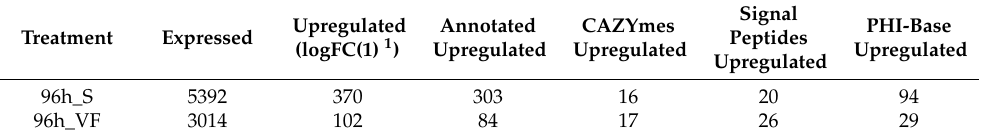
(Table S4). A subset of 303 genes expressed in 96h_S were not detected in 96h_VF elms, whereas only one gene (OnuG2030) expressed in 96h_VF ( n = 1.7 transcripts) was not in 96h_S elms. Table 2. Summary of categories in Ophiostoma novo-ulmi ssp. americana differentially expressed genes. Treatment Expressed